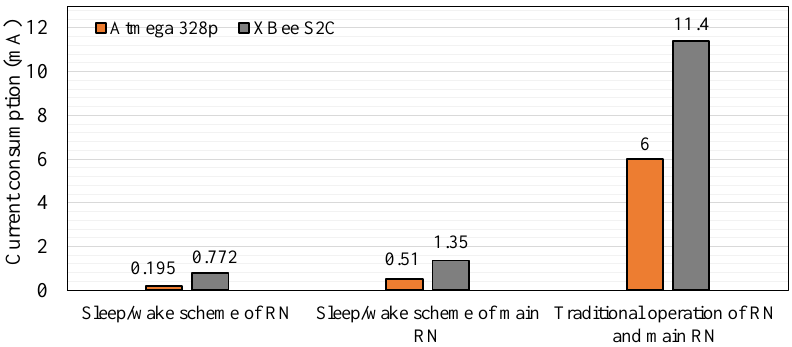
Figure 12. Current consumption of the components of the router and main router nodes with and without the sleep/wake scheme.